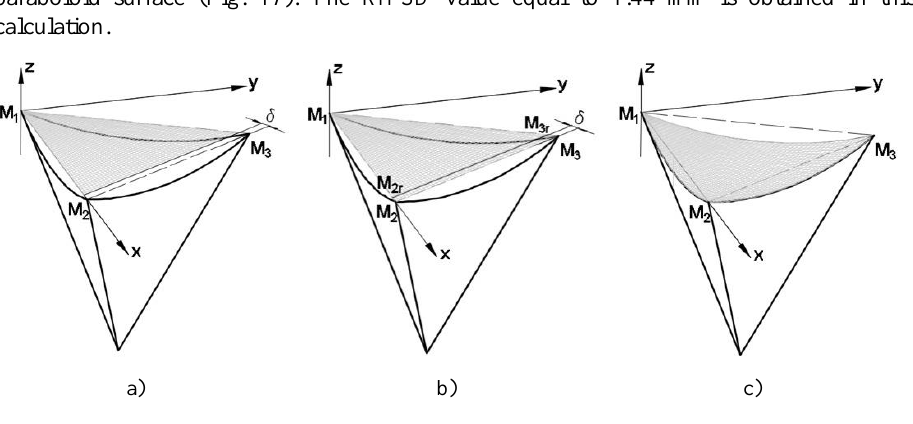
Fig. 17. Points corresponding to the arcs heights are shifted by 2 mm towards the external normal to the paraboloid